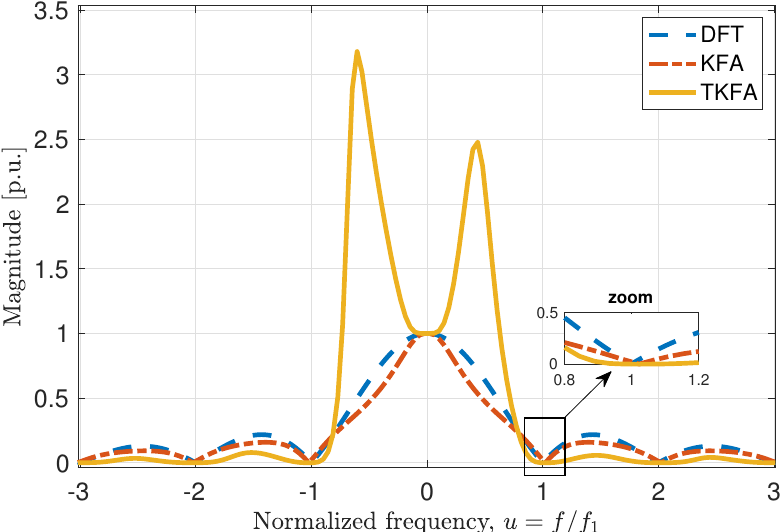
Figure 5. Magnitude response of DFT, KFA and TKFA algorithms, with Q = 10 − 3 , P r = 10 10 and R = 1.